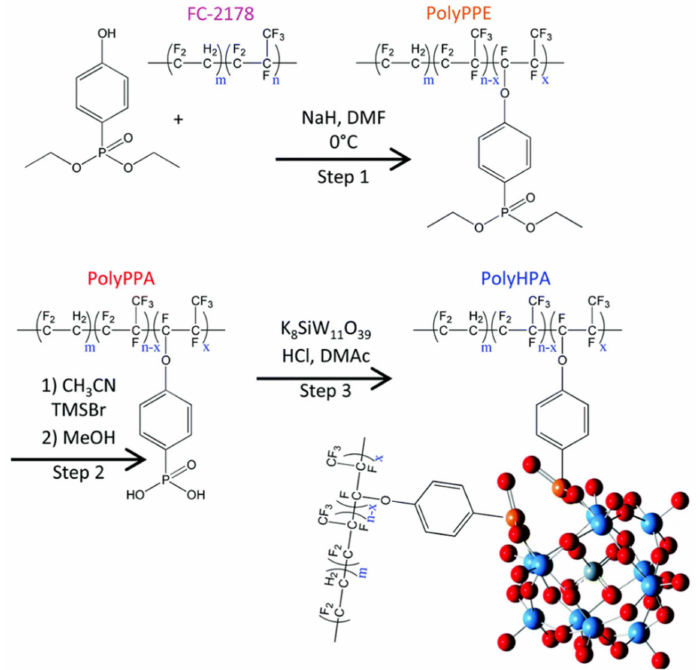
Figure 10. Full synthetic reaction scheme for the synthesis of PolyHPA. Reprinted with permission from [123]. Copyright (2018) The Royal Society of